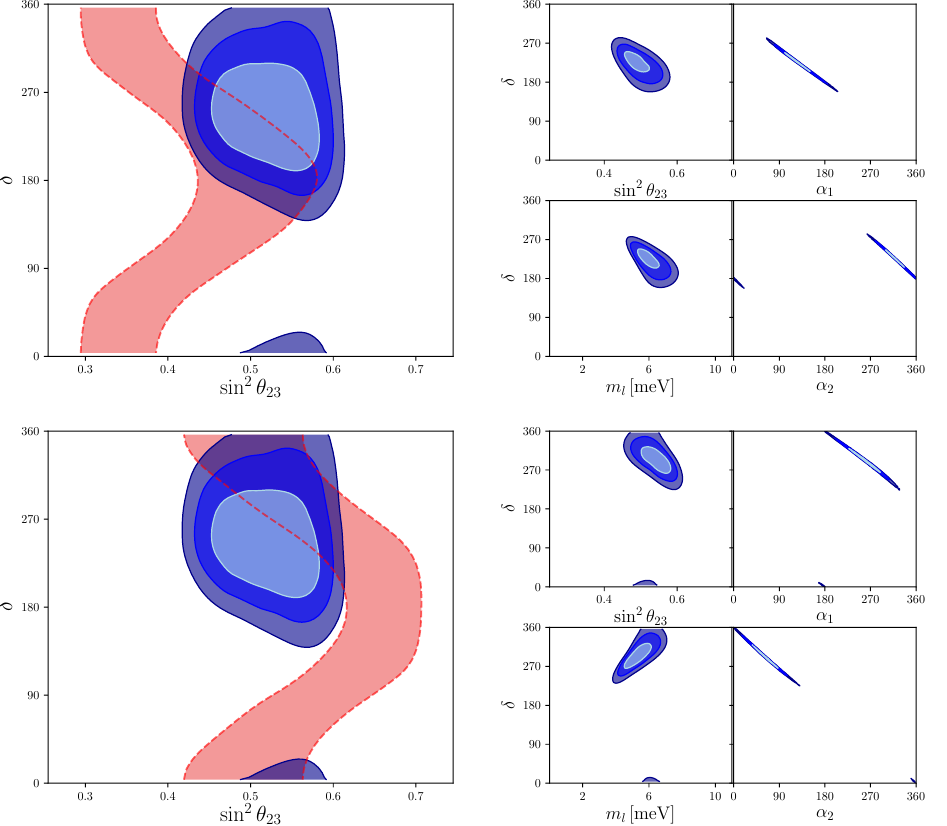
Figure 1 . On the left of the panels we present the NuFIT results [21, 22], in the s 2 the global (cid:12)t to neutrino data (blue-gray coloured contours correspond to 68.27% 95.45% 99.73% C.L. regions ) as compared with the prediction of the textures, in red, obtained when the rest of the oscillation parameters are varied in 3 (cid:27) . On the right we present the new (cid:12)t to the data, as discussed in the text, when the constraints from the textures are imposed. The upper panel is for the A 1 texture and the lower one for the A 2 texture, which are only allowed in the NO case.